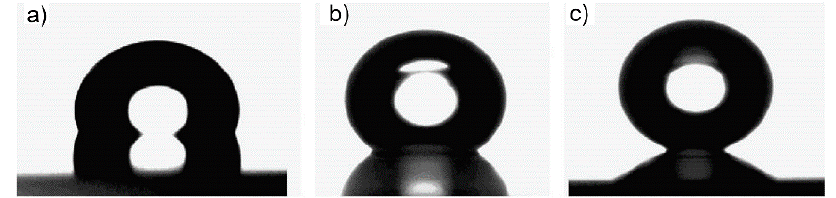
Figure 6. Photographs of water droplets on ( a ) flat; ( b ) LIPSS and ( c ) double-scale structure stainless steel surfaces after silanization. Reprinted from Wu et al . [51], Copyright 2009, with permission from Elsevier.